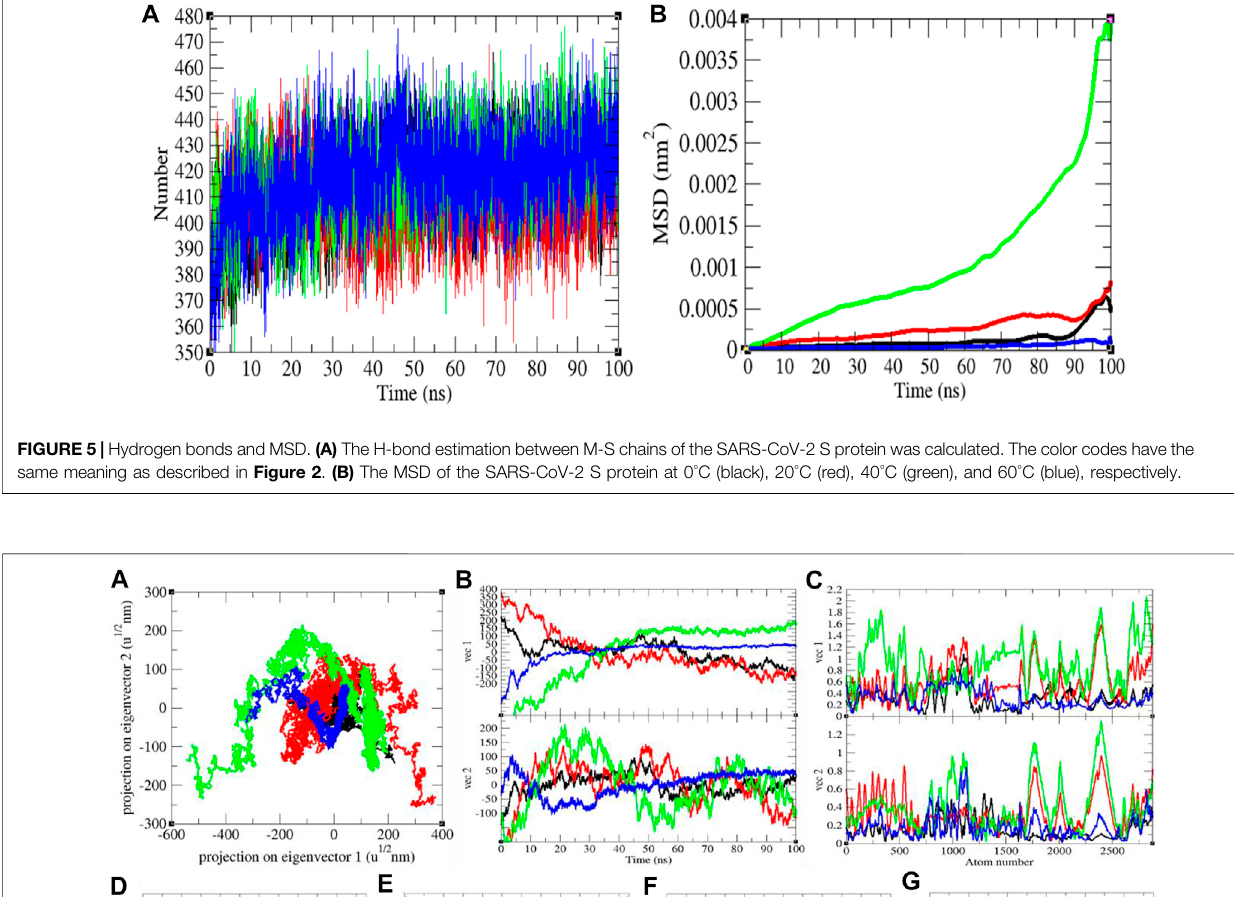
Frontiers in Molecular Biosciences |